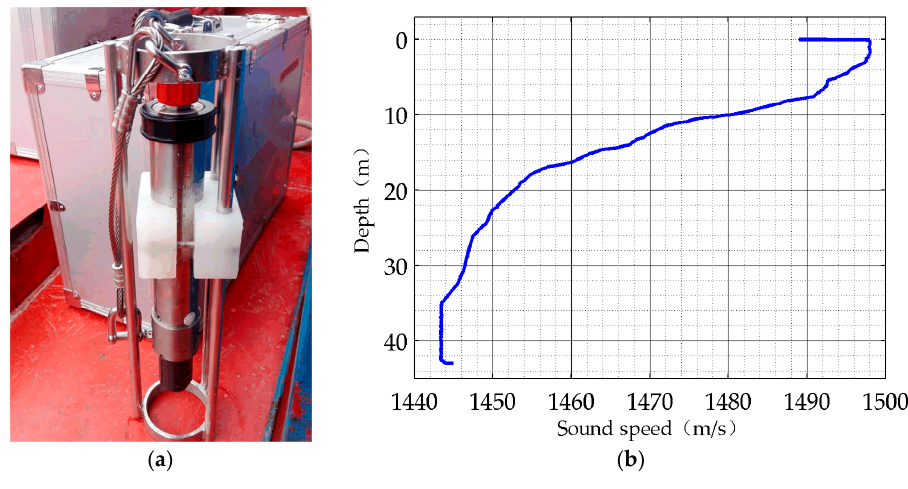
Figure 11. ( a ) The CTD; ( b ) The sound speed profile.